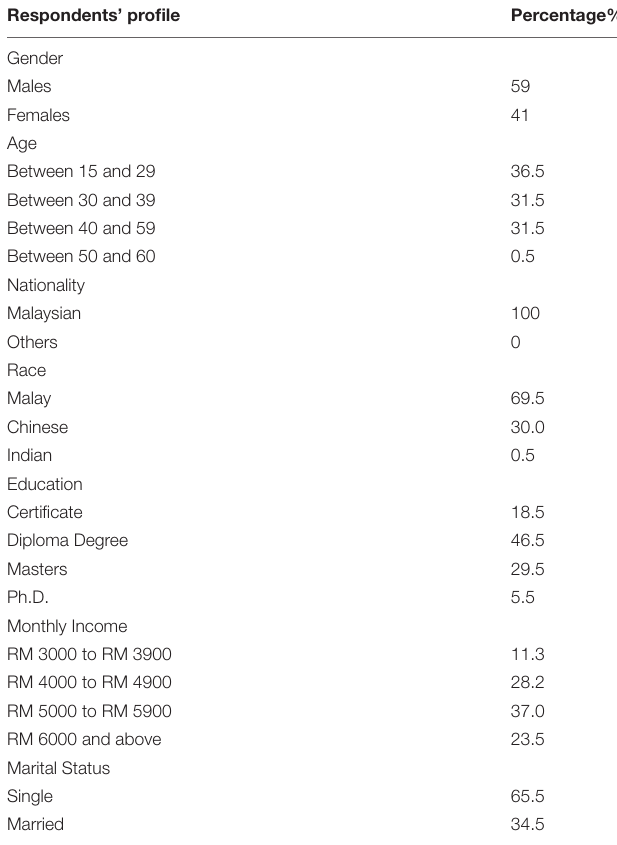
TABLE 1 | Information of the